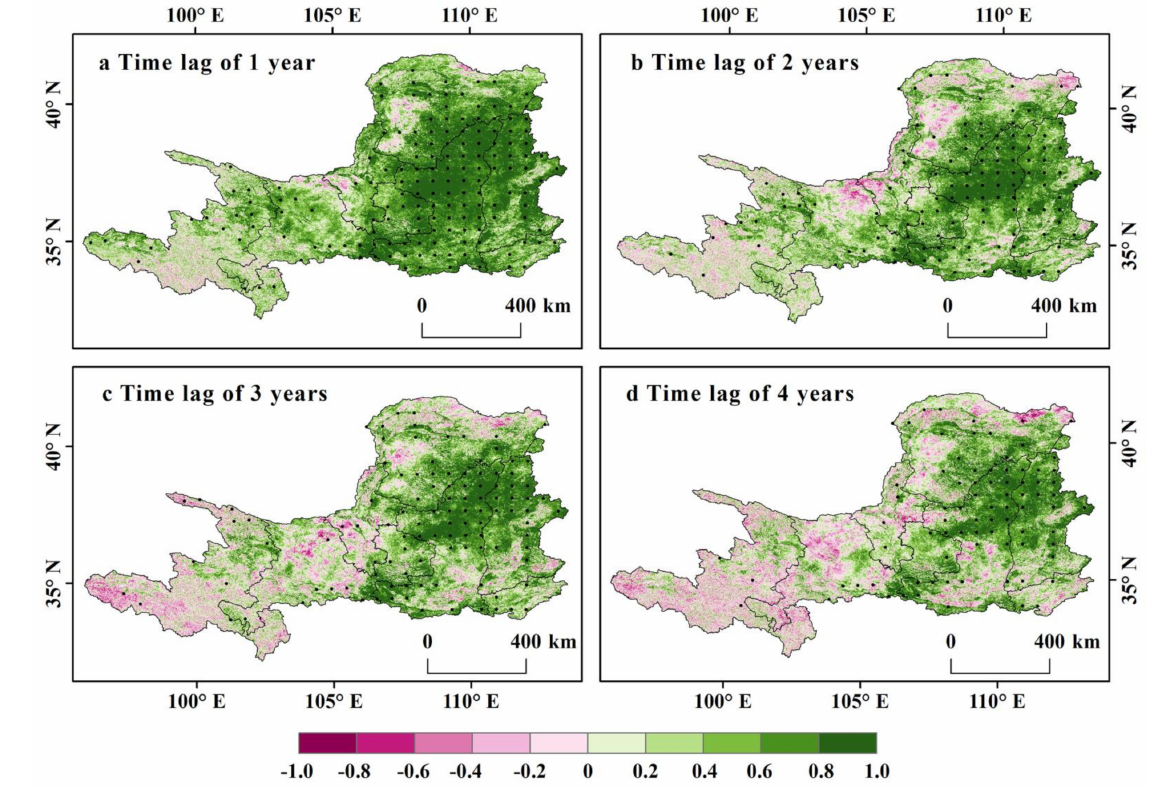
Figure 7. Spatial distribution of the partial correlations between NDVI of each year and that of the lag time, after controlling for the climate variable of both